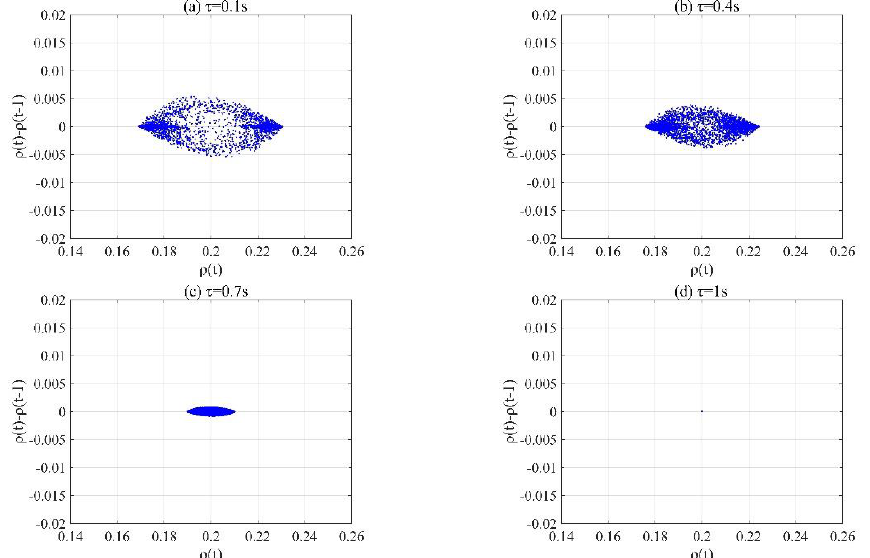
Figure 9. Plots of density versus density difference corresponding to Figure 7.